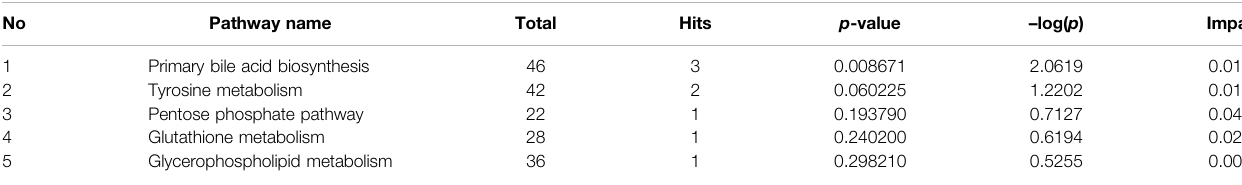
TABLE 3 | Results of metabolic pathway